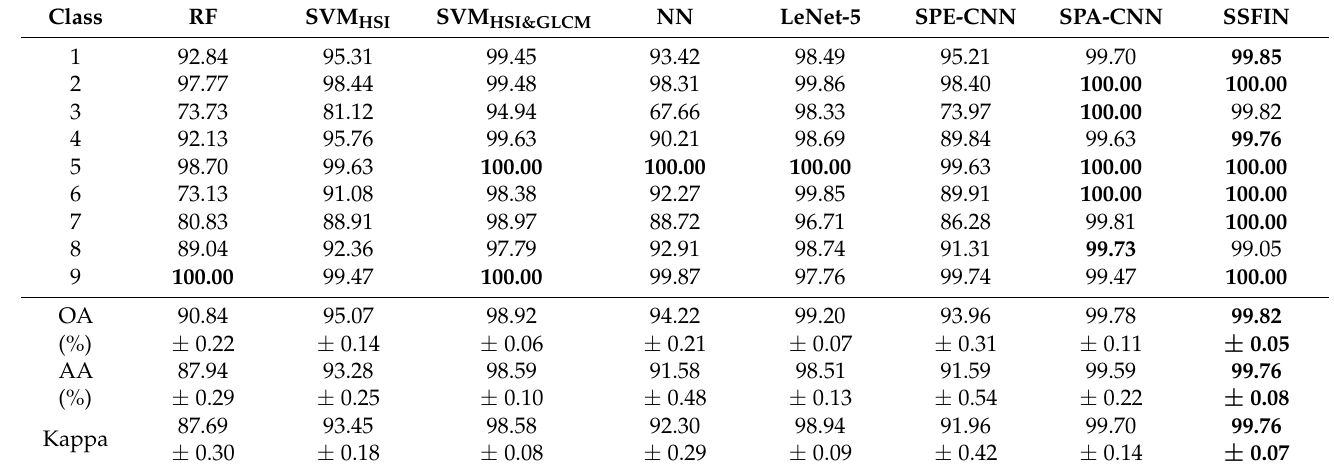
Table 6. Classification results of different methods for the Pavia University